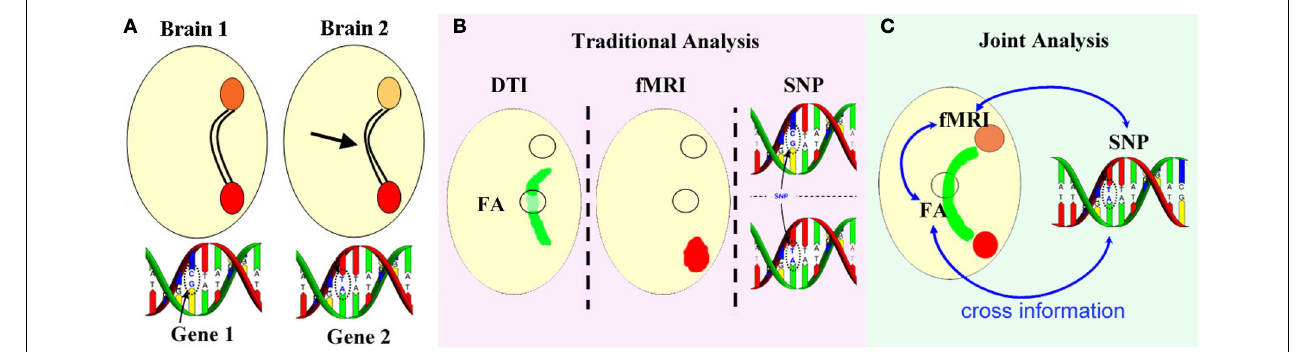
connectivity, while fMRI activity at the input (red circles) is unaffected. Traditional separate analysis of each modality (B) would not reveal such modal interactions, whereas a joint analysis (C) may detect the underlying